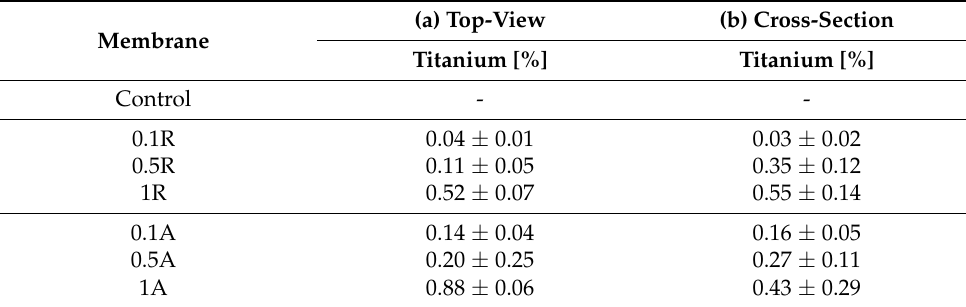
Table 2. Elemental analysis of titanium via EDX method on surface ( a ) and in cross-section ( b ) of control membrane and membranes with the addition of titanium dioxide nanoparticles.